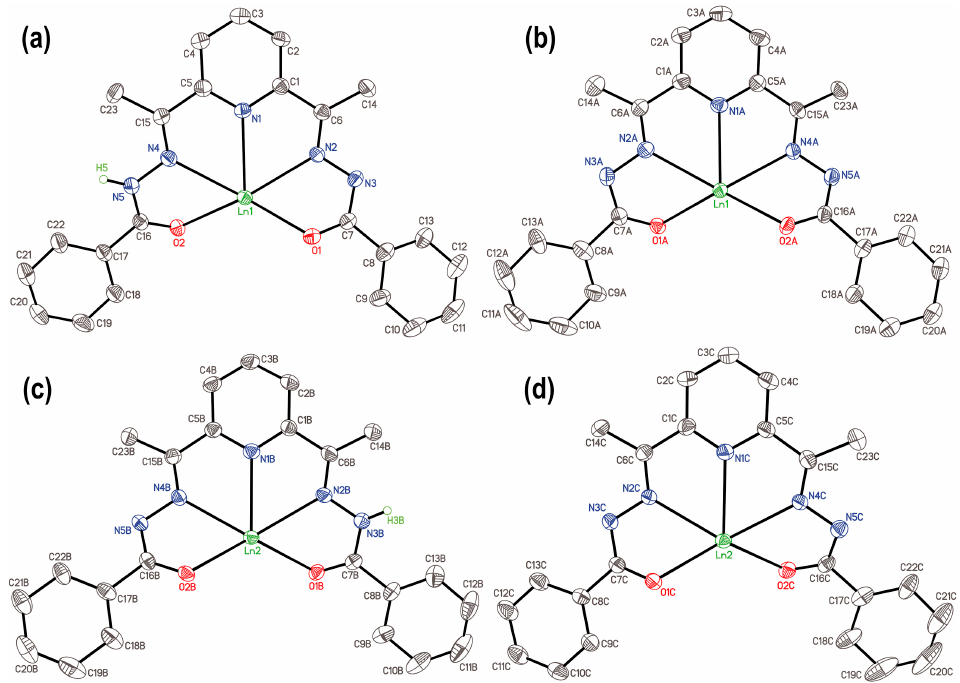
Figure 4. General labeling scheme for main molecules of 1 , 3 and 4 : ( a , b ) for first crystallographically independent molecule in 1-Dy and 3-Ho and ( c , d ) for second independent molecule in 1-Dy and 3-Ho . In complex 4-Er , the hydrogen atom in a monoanionic ligand is localized at position N5A (Figure 2). On each part of the image one ligand, and hydrogen atoms (except one hydrogen atom of a partially monoanionic ligand) are not shown for clarity.